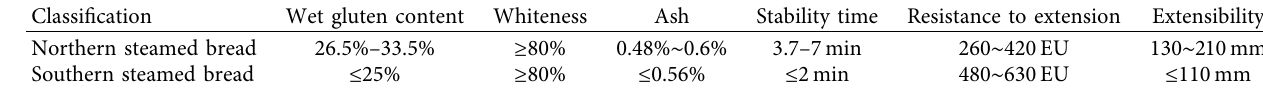
Table 4: Quality characteristics of wheat flour for making different steamed bread.